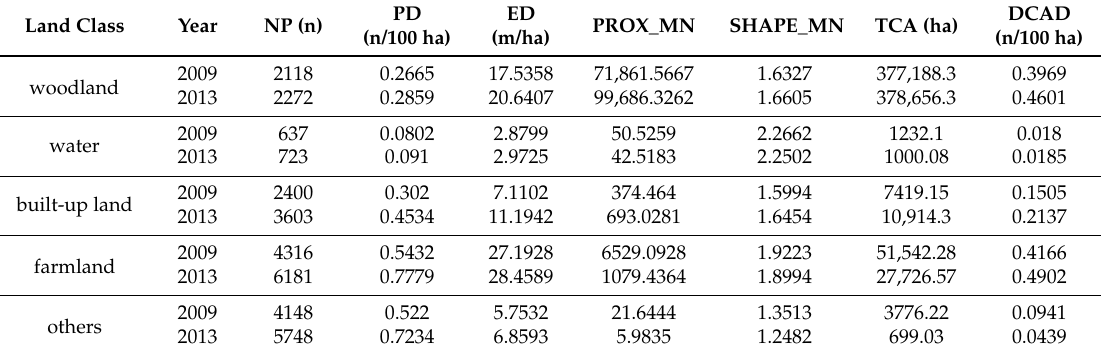
Table 4. Metrics at the class level in Lijiang River Basin between 2009 and